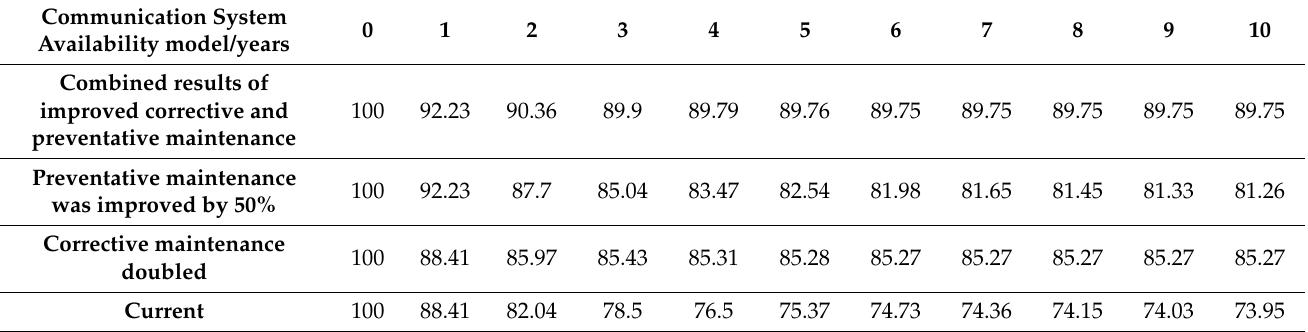
Table 5. Simulation results of single-shaft underground mine communication system reliability without standby system (included preventive and corrective maintenance analysis).